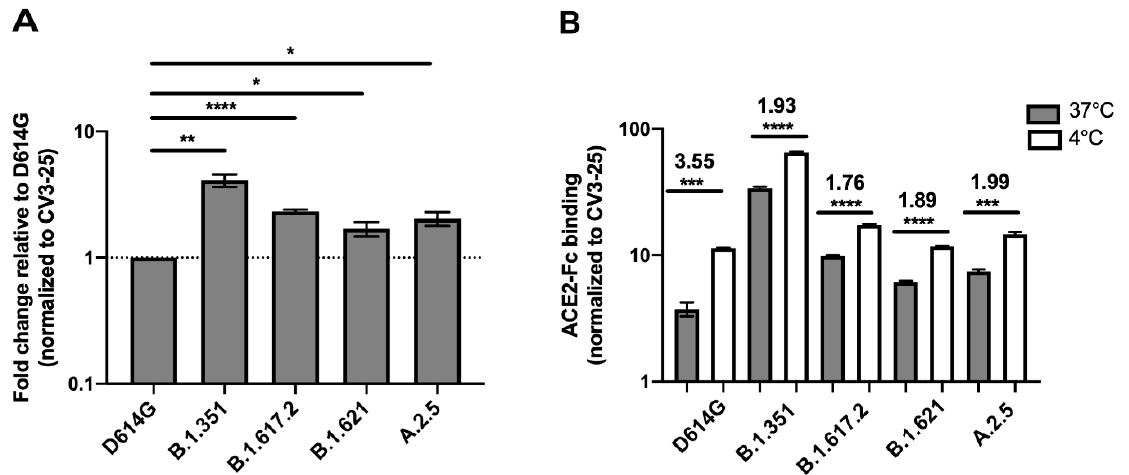
Figure 1. Spike glycoproteins interaction with ACE2. HEK 293T cells were transfected with the indicated SARS-CoV-2 Spike variants. 48 h post transfection, cells were stained with ACE2-Fc or with CV3-25 Ab and analyzed by flow cytometry. ACE2-Fc binding to the different full Spike variants is presented as a ratio of ACE2 binding of D614G Spike ( A ). The graph represented ACE2-Fc binding to the different full Spike variants at 37 °C and 4 °C ( B ). For each Spike variant, statistical significance and fold changes of ACE2 binding at 4 °C vs. 37 °C is indicated in ( B ). ACE2-Fc binding was normalized to CV3-25 binding in each experiment and at each indicated temperature. Error bars indicate means ± SEM. Statistical significance was performed using Mann–Whitney U test (* p < 0.05; ** p < 0.01; *** p < 0.001; **** p < 0.0001).